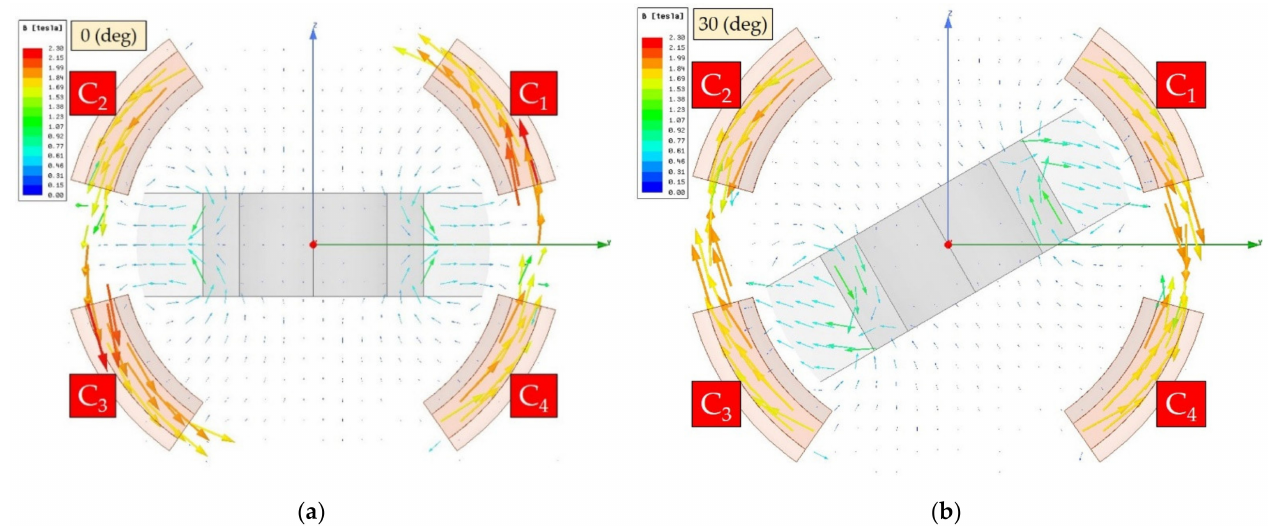
Figure 11. The magnetic field distribution due to Amp è re’s circuital law for the rotation about the X -axis when the rotor is tilted at ( a ) 0 ◦ and ( b ) 30 ◦ along the X